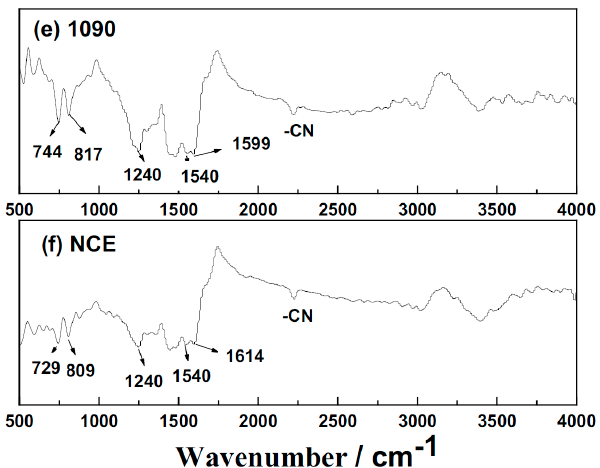
Figure 5. Fourier-transform far-infrared (FTIR) spectra of NCE, EPCHPOSS–BPh, 1090, 2080, 3070, and 4060 copolymers.